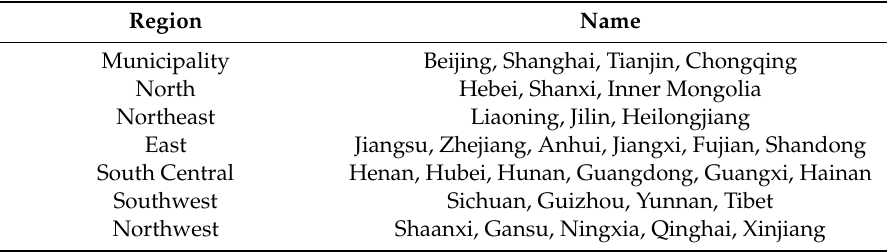
Table 8. The regional division information of various provinces in China. Region